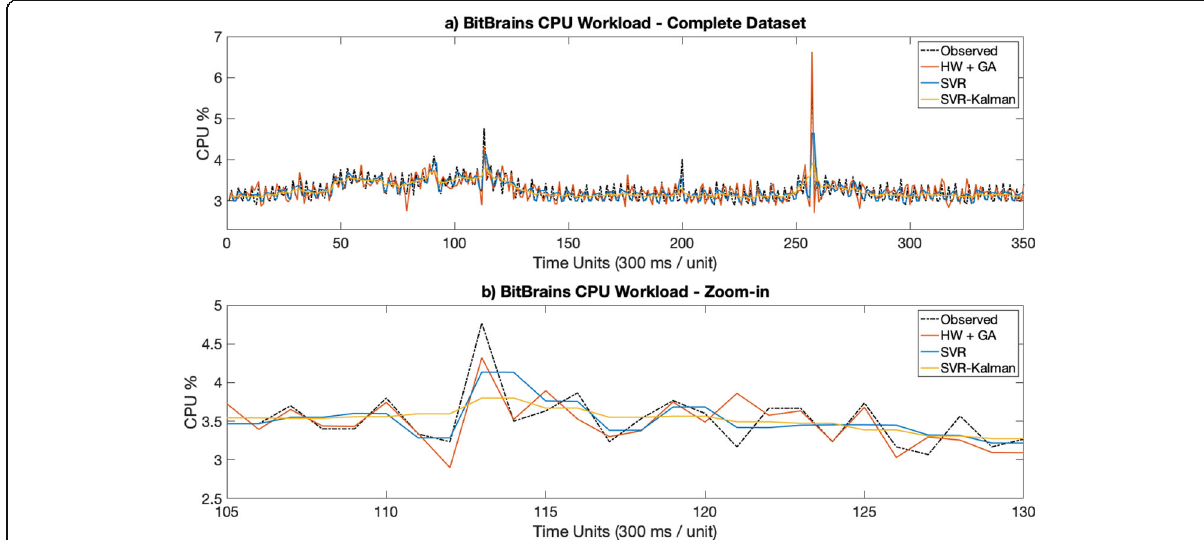
Fig. 6 BitBrains Observed and Estimated data: a Complete dataset, b Zoom-in